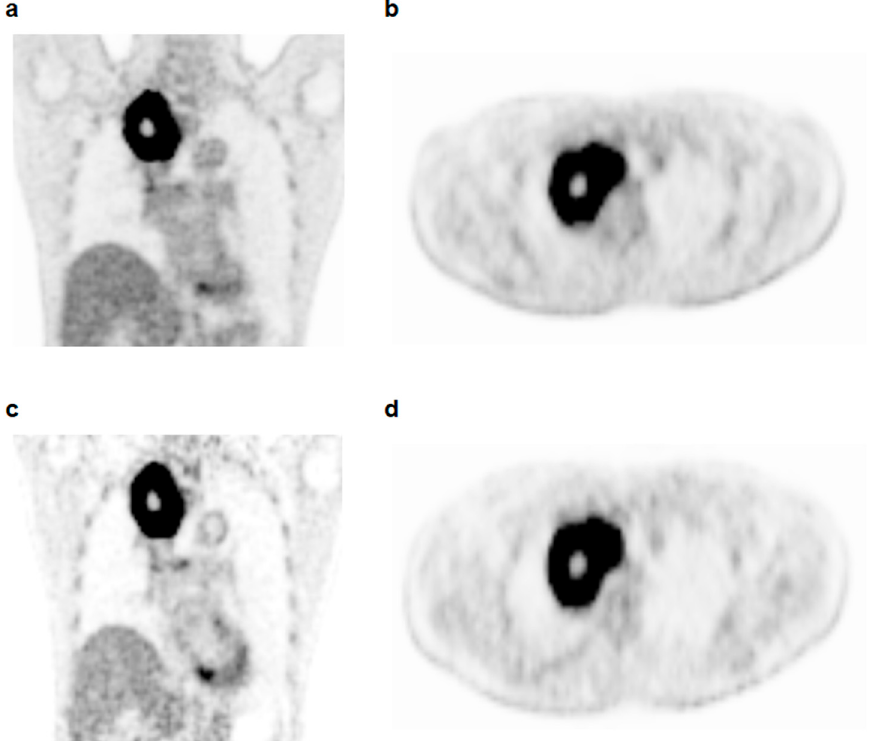
Figure 1. Coronal ( a ) and transaxial ( b ) images in early FDG PET/CT scans and coronal ( c ) and transaxial ( d ) images in the delayed FDG PET/CT scans of a 53-year-old man histopathologically diagnosed with adenocarcinoma. In both early and delayed PET/CT images, the primary lung cancer lesion was delineated using a threshold value of 7.06 for the early PET/CT images and 7.61 for the delayed PET/CT images determined by Nestle’s adaptive threshold method ( b , d ). The maximum SUV, MTV, and TLG were 21.9, 114.6 cm 3 , and 1218.2 g for early PET/CT and 26.9, 175.3 cm 3 , and 2236.8 g for delayed PET/CT. Therefore, the ∆ MTV and ∆ TLG were 53.0% and 83.6%, respectively. The patient was clinically diagnosed with T4N2M0 and received concurrent chemoradiotherapy. The patient had not experienced cancer progression during 32.7 months of follow-up.